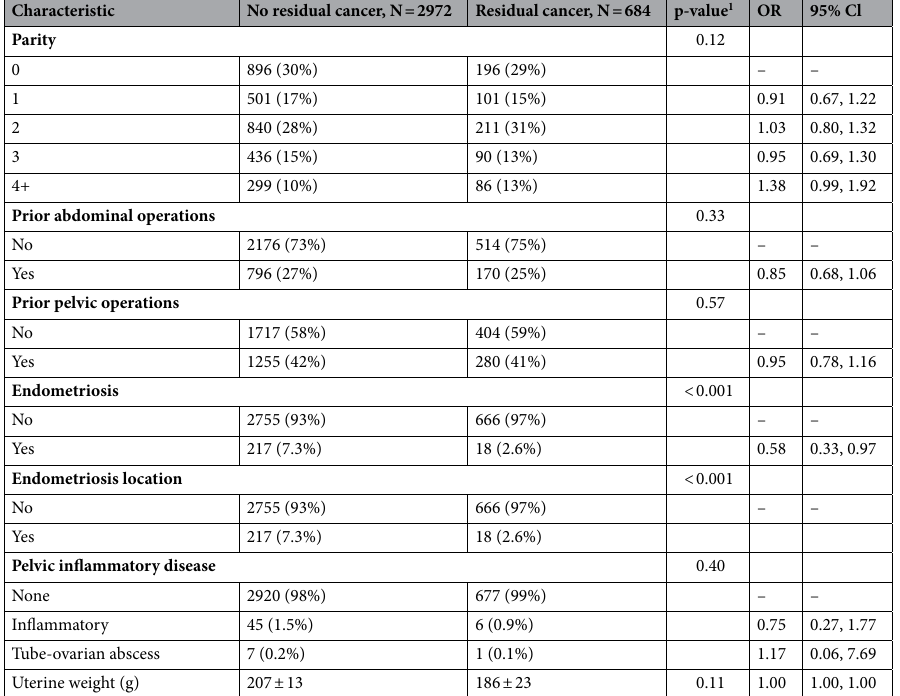
Table 1. Clinical history/surgical information summary table. OR odds ratio, CI confidence interval. 1 Continuous Variable: one-way ANOVA, Binary Variable: Fisher’s Exact Test, Categorical Variable: Chi- Squared